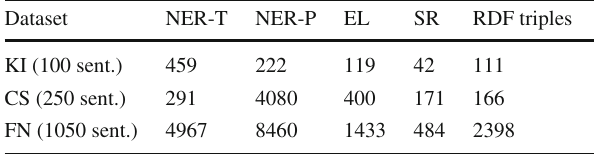
Table 7 Results of precision for entity extraction and linking Total